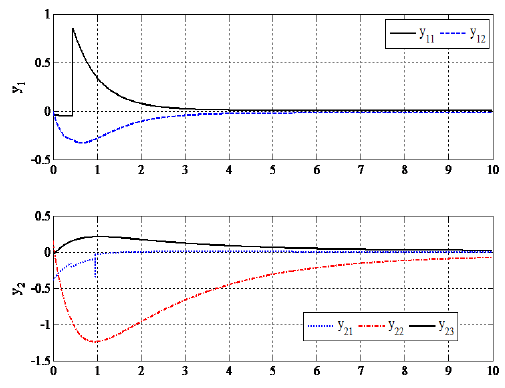
Fig. 2: Outputs trajectories of the overall closed-loop interconnected switched Takagi-Sugeno system.